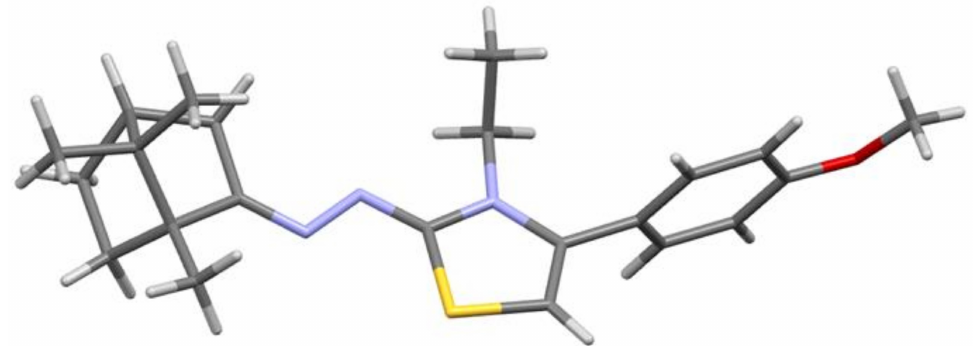
Figure 2. Structure of compound 7c according to X-ray diffraction data (CCDC 2181023). Crys- tallographic data for 7c : C 22 H 29 N 3 OS, M 383.54, orthorhombic, P2 1 2 1 2 1 , a 9.7454(4), b 12.4168(6), c 17.905(1), Å, V 2166.6(2)Å 3 , Z 4, D calcd 1.176 g · cm –3 , F(000) 824, colorless, (0.61 × 0.51 × 0.42) mm 3